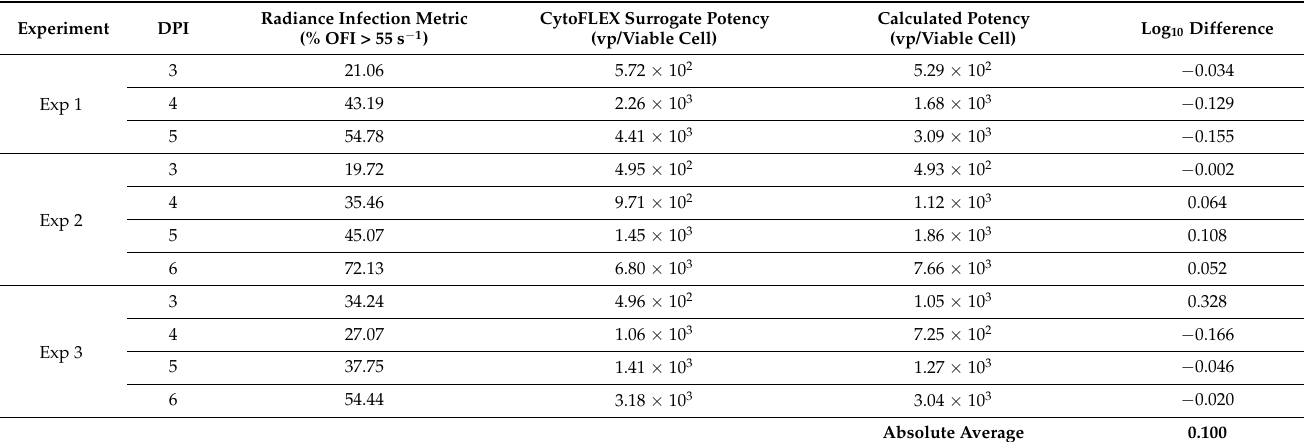
Table 2. Calculated Potency Values for AV1-infected bioreactor samples. Table detailing days post- infection (DPI), Radiance infection metric, total virus particle counts used as surrogate potency, and calculated potency in terms of vp/viable cell based on the correlation between the LFC data and flow cytometry data for all three AV1 3 L bioreactor experiments. The average log 10 difference between the measured and calculated potencies for each sample timepoint as well as the absolute average for all samples across all three experiments are given in the final